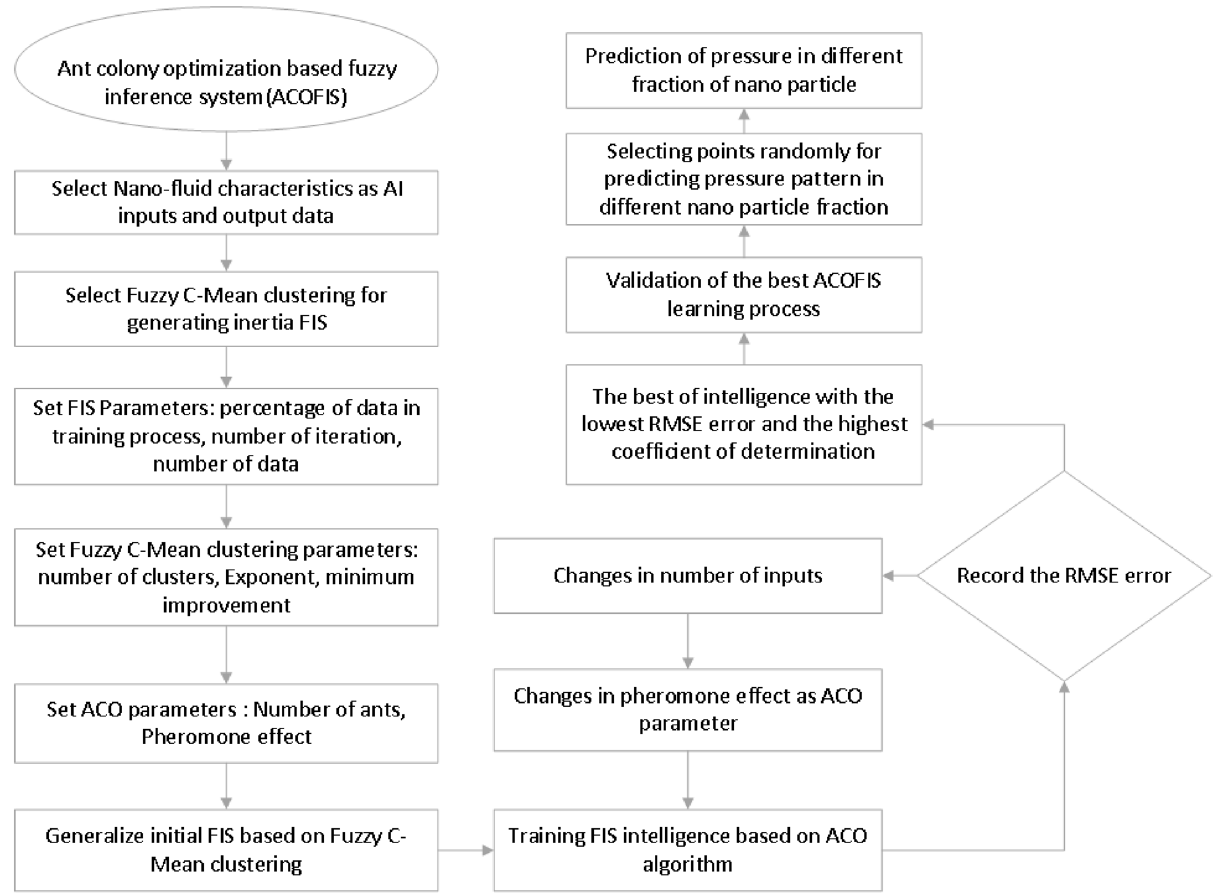
Figure 1. Schematics of combination of ant colony algorithm with fuzzy